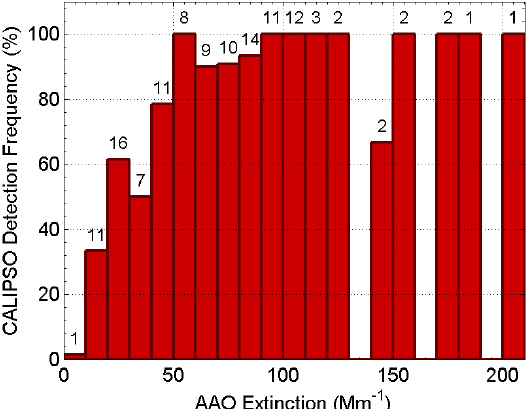
Fig. 16. CALIPSO extinction detection frequency as a function of AAO in situ extinction. Numbers above bars indicate the number of valid CALIPSO aerosol extinction retrievals falling within each AAO extinction range bin.